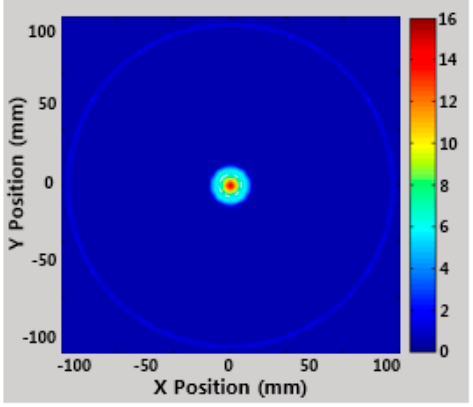
Figure 24. Circular defect imaging.